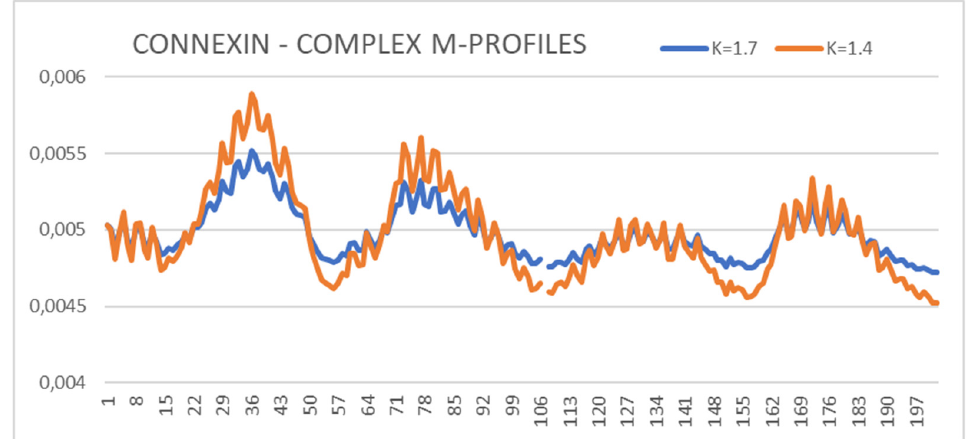
Figure 1. The summary of M distributions for connexin in the presence of Ca 2+ (K = 1.7) and in its absence (K = 1.4)—status of chain A in complexes is shown. The numbers on the x-axis represent the order of residues in a chain—the numbers are not the positions as it is given in PDB.